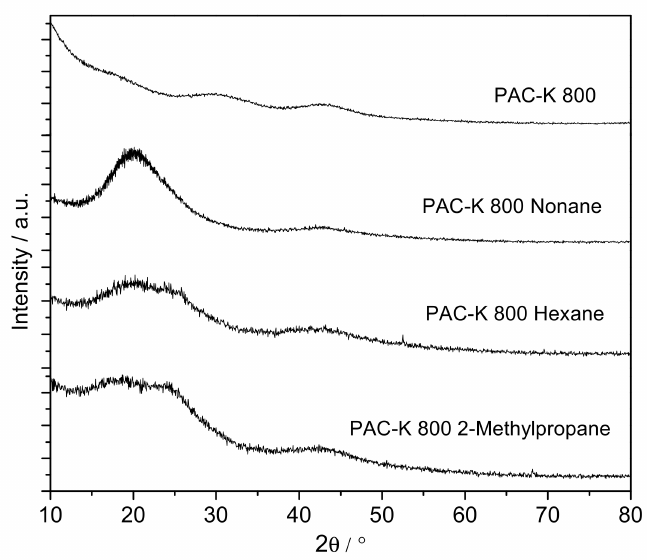
Figure 3. XRD profiles for the petroleum-pitch activated carbon (PAC-K 800) before and after incorporation of di ff erent